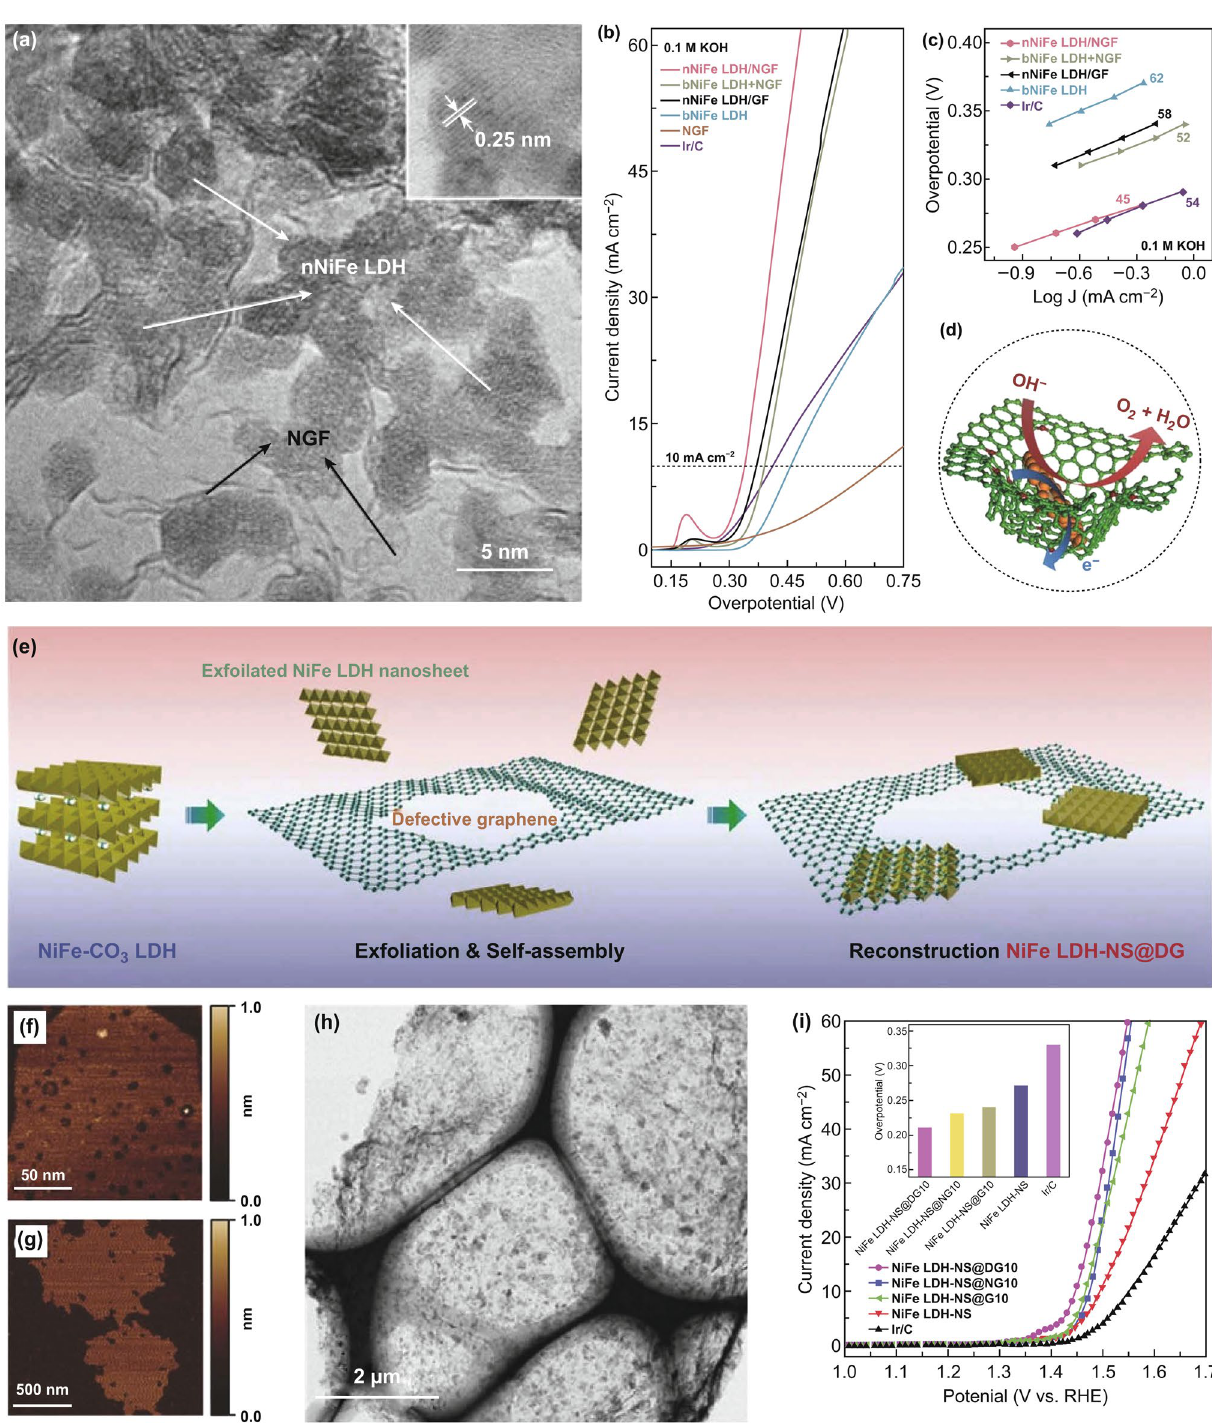
Fig. 10 a TEM image and HRTEM image (inset of a ) of nNiFe LDH/NGF catalyst. b 95% iR ‑corrected LSV curves of the catalysts at 5 mV s −1 in 0.1 M KOH. c Tafel plots of the different catalysts for comparison. d Schematic diagram of the spatially confined nNiFe LDH/NGF hybrids. Reproduced with permission of Ref. [115]. Copyright 2015 WILEY–VCH Verlag GmbH& Co. KGaA, Weinheim. e Schematic diagram of